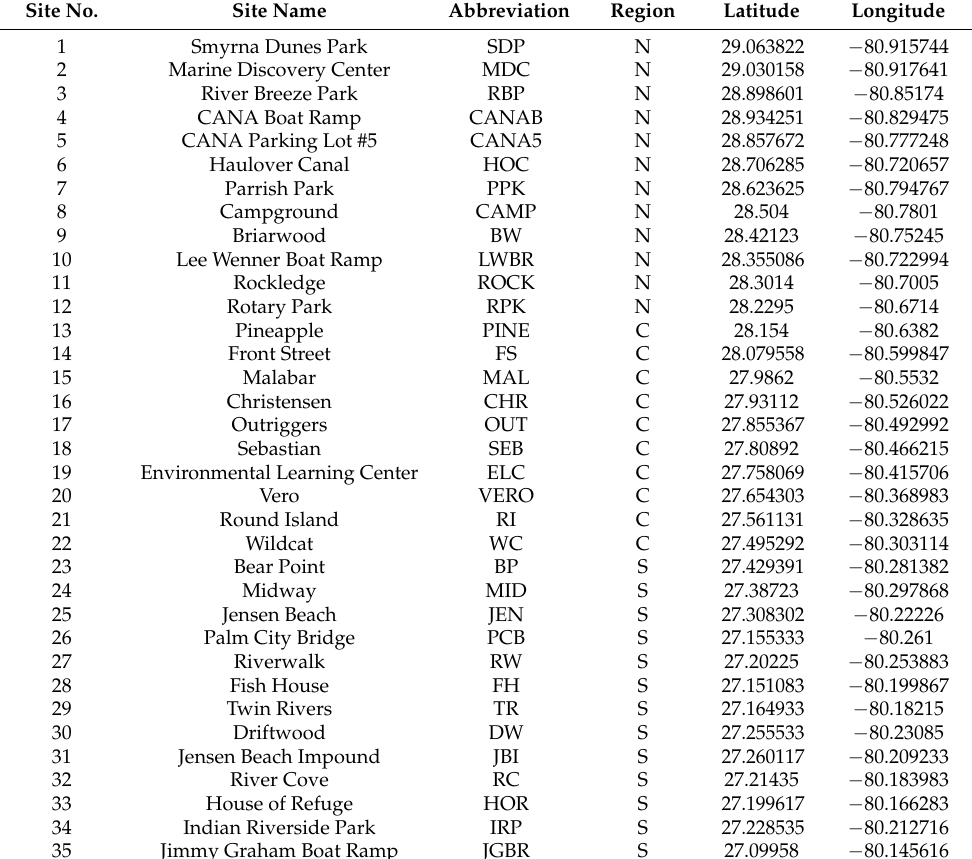
Table 1. Indian River Lagoon water sampling sites from north to